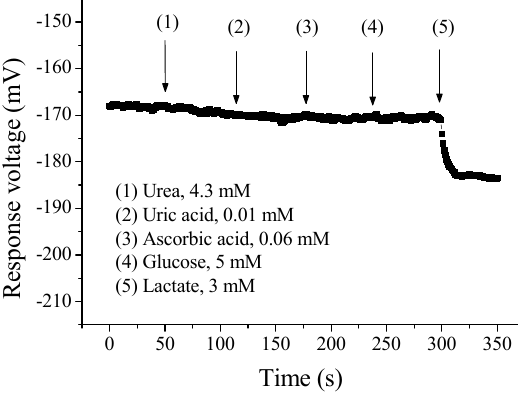
Figure 10. The anti-interference effect of flexible arrayed lactate biosensor against various substances.